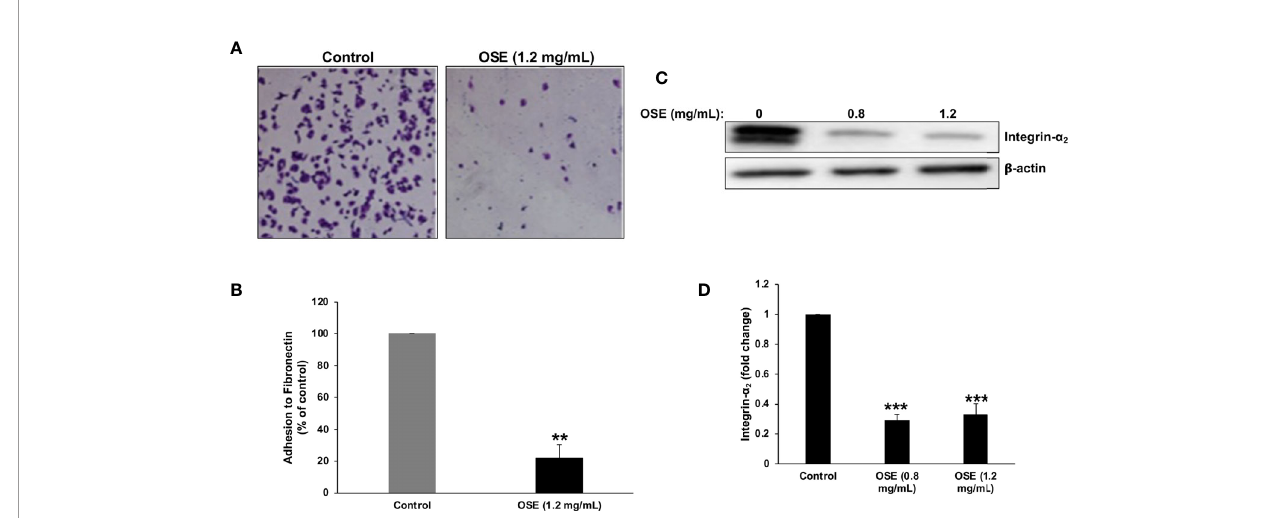
FIGURE 4 | OSE inhibits adhesion of MDA-MB-231 cells to fi bronectin and downregulates integrin a 2. (A, B) OSE impairs the ability of MDA-MB-231 cells to adhere to fi bronectin. Cells were treated with OSE (1.2 mg/ml) and allowed to adhere to fi bronectin for 1 hr. Representative photomicrographs show the effect of OSE on MDA-MB-231 adhesion. Values are represented as mean ± SEM of relative fold inhibition of control cells (**p < 0.005). (C, D) Cells were treated with OSE (0.8 mg/ml) for 24h, and the level of integrin a 2 was detected by Western blotting. Values represent mean fold change of three independent replicates. One-way ANOVA was performed (***p < 0.001).